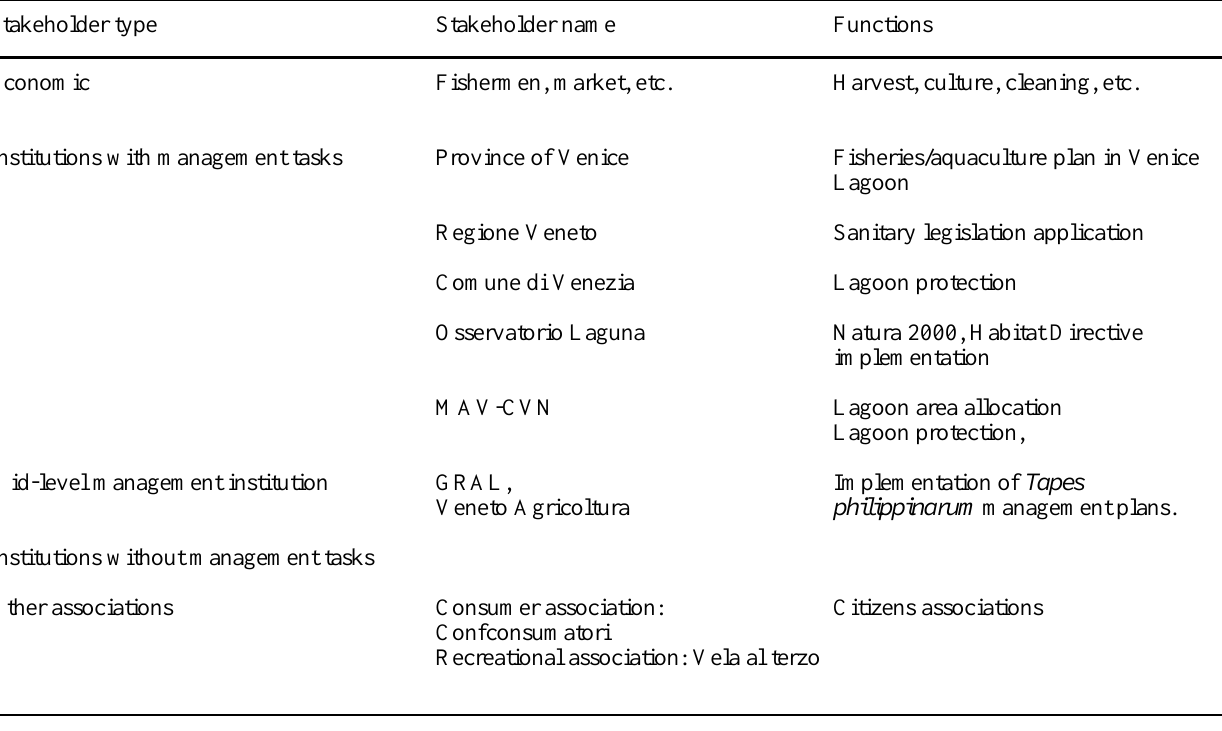
Table 1. Stakeholders involved in the